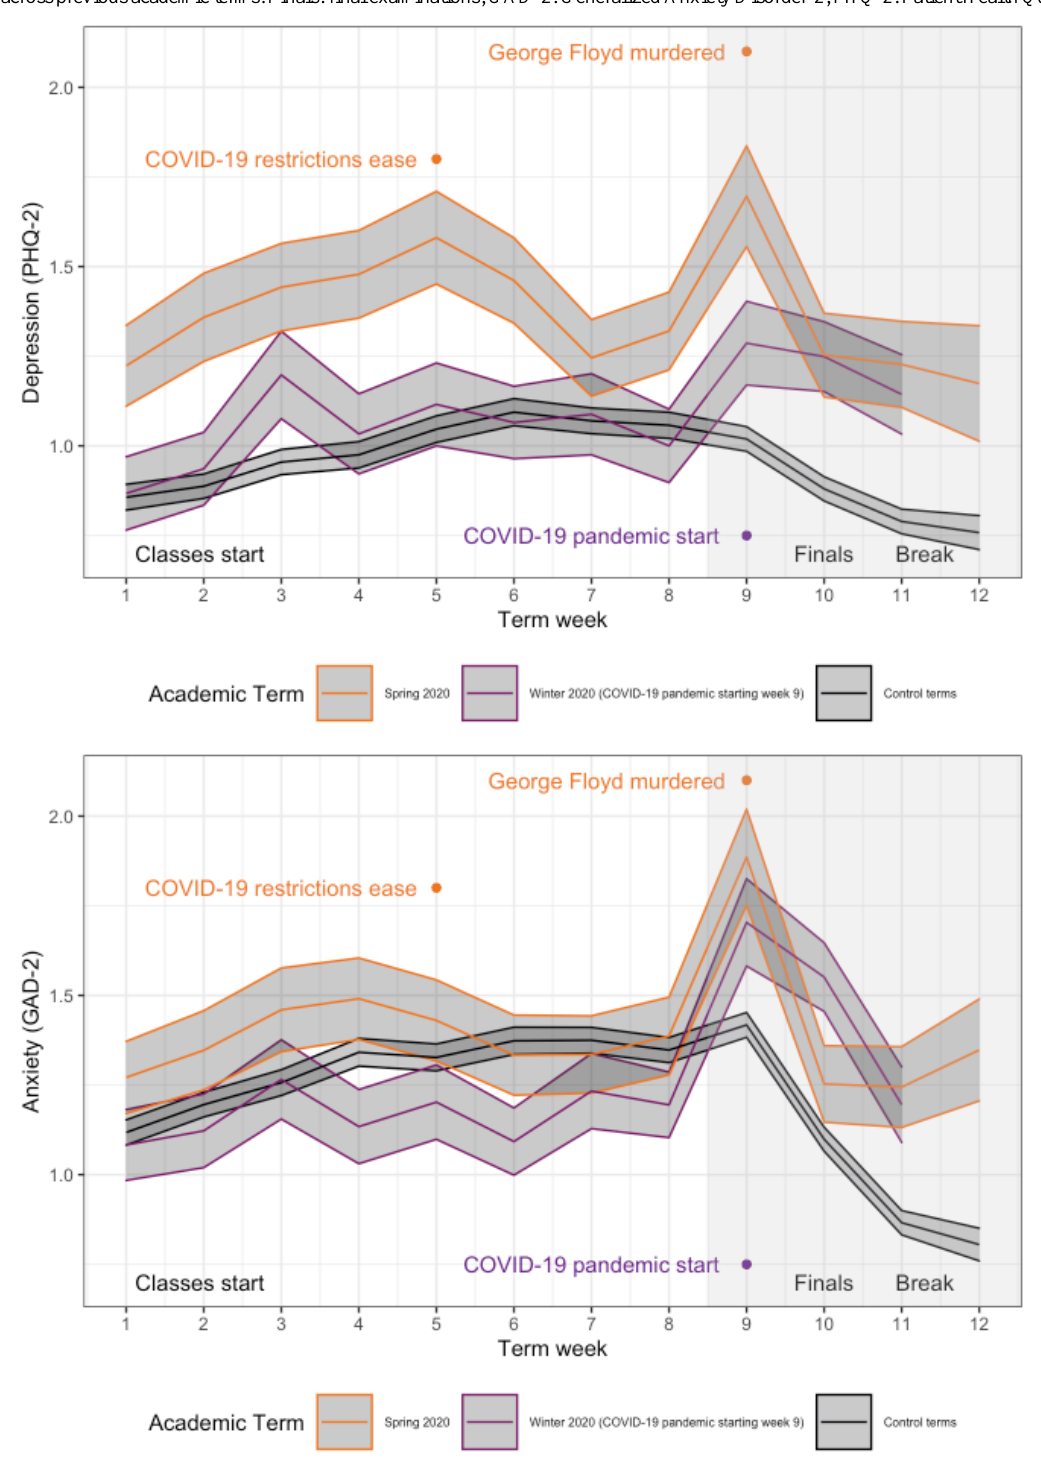
Figure 3. Depression (top) and anxiety (bottom) scores across an academic term and the first 2 weeks of break, with the term influenced by the outbreak of the COVID-19 pandemic as a separate line. The shaded ribbons represent the standard error for each week. Winter 2020 weeks influenced by policy changes related to COVID-19 are represented with a shaded box from weeks 9 to 12. Colored text corresponds to the term in which the event took place. Depression and anxiety were measured with the PHQ-2 and GAD-2 scales through the StudentLife app. Control terms include data from the same